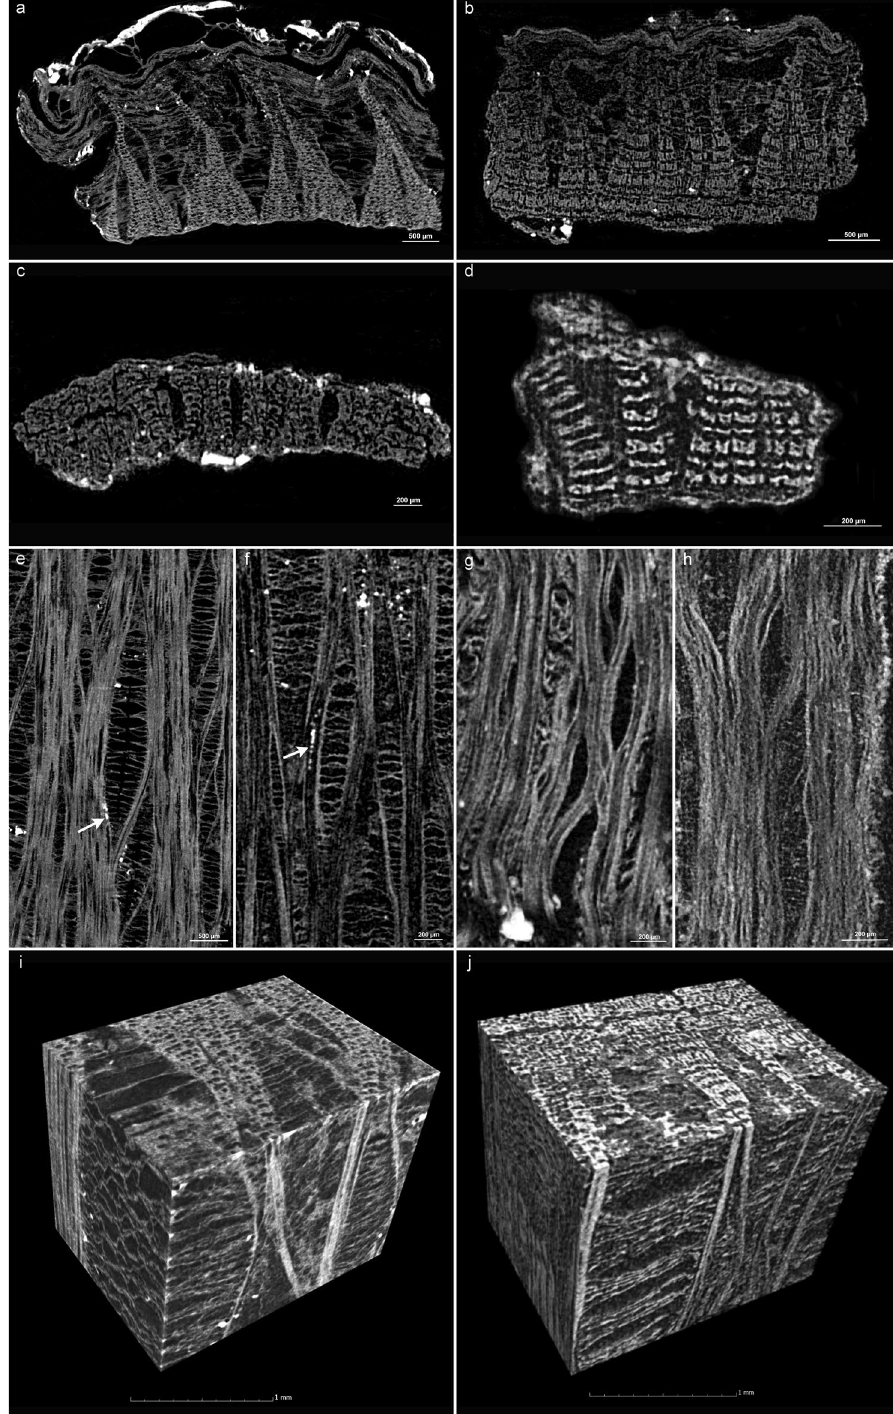
Figure 7. Characteristics of lime in the µCT data of the archaeological samples (Table 1b) in the cross sections of the sample 5 ( a ), 6 ( b ), 7 ( c ) and 8 ( d ) and the tangential section of sample 5 ( e ), 6 ( f ), 7 ( g ) and 8 ( h ). The arrows indicate the elongated crystals. Three-dimensional µCT representations of sample 5 ( i ) and 6 ( j